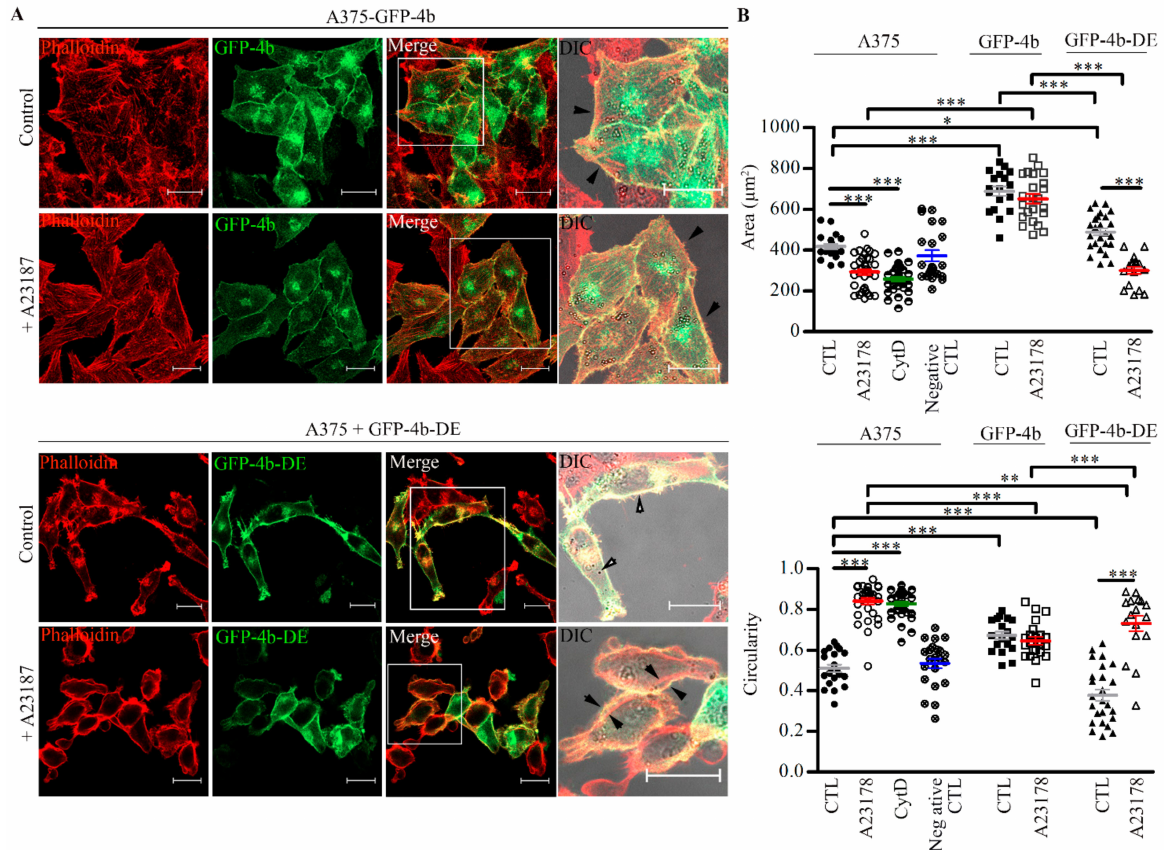
Figure 8. A375-GFP-PMCA4b but not the parental or the non-functional mutant expressing PMCA4b-DE cells maintain shape after Ca 2+ overload. ( A ) A375-GFP-PMCA4b cells or A375 cells transiently expressing GFP-PMCA4b-DE were treated with 2 µ M A23187 in HBSS buffer containing 2 µ M Ca 2+ for 10 min at 37 ◦ C. Confocal and DIC microscopy images were taken after labeling with Phalloidin-TRITC. Scale bar, 20 µ m. Right images show cells with higher magnification, scale bar, 20 µ m. Arrowheads show the position of actin in relation to the cell periphery. ( B ) Area and circularity parameters were analyzed for each cell type ( n = 17–33) by ImageJ software. The mean ± S.E.M values of data are presented as a scatter plot. Confocal microscopy images of cells incubated in the presence or absence of cytochalasin D (CytD) or A23187 are shown in Figure S7 (* p < 0.05, ** p < 0.01, *** p <